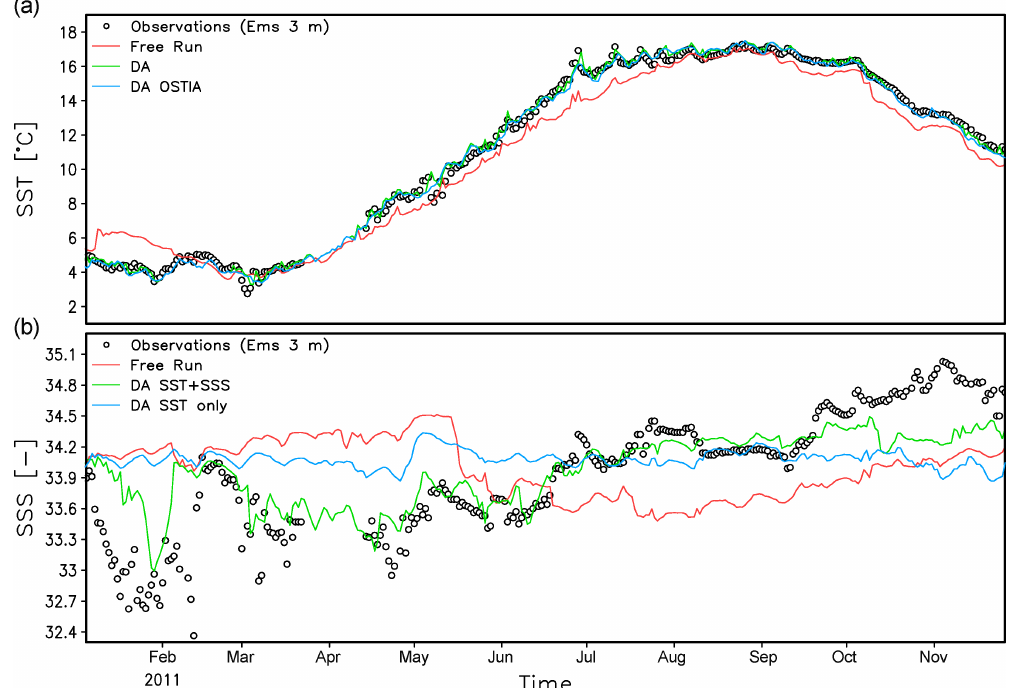
Figure 12. Validation of the simulated SST (a) and SSS (b) against the MARNET observations during 2011 for the Ems data station (see Fig. 1 for its position). Black circles are MARNET observations, the red line is the free run, the blue line corresponds to the case when only SST is assimilated, and the green line shows the results when the assimilation of SST and SSS from Ferry Box is added. The temporal resolution of the data is hourly and it is smoothed with a 24h running mean in order to filter out the daily cycle. The different experiments and data are shown in the